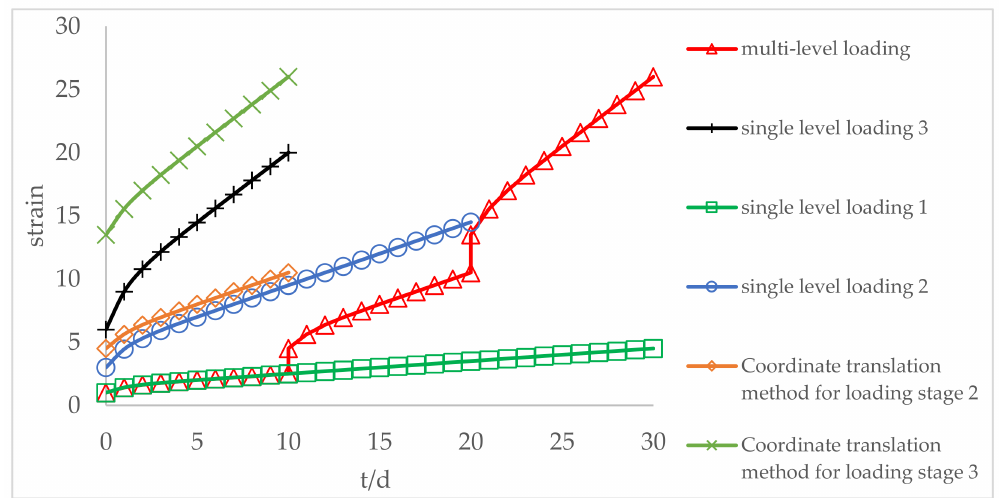
Figure 13. Comparison of creep strains between single-step loading and multi-step loading for Nishihara